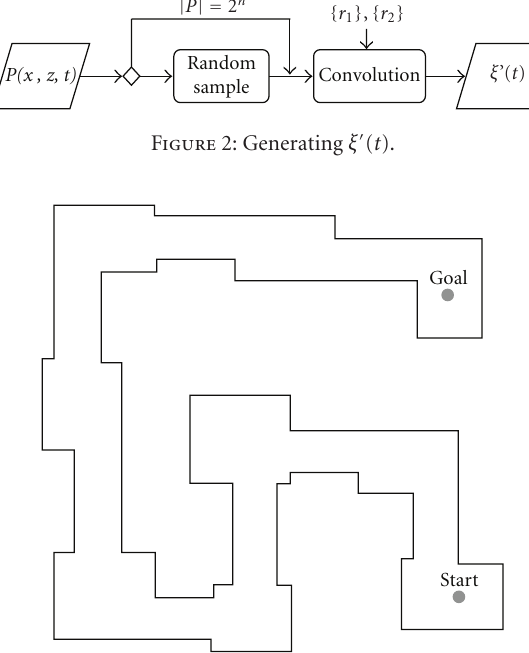
Figure 3: Trial 56 random, multiroom